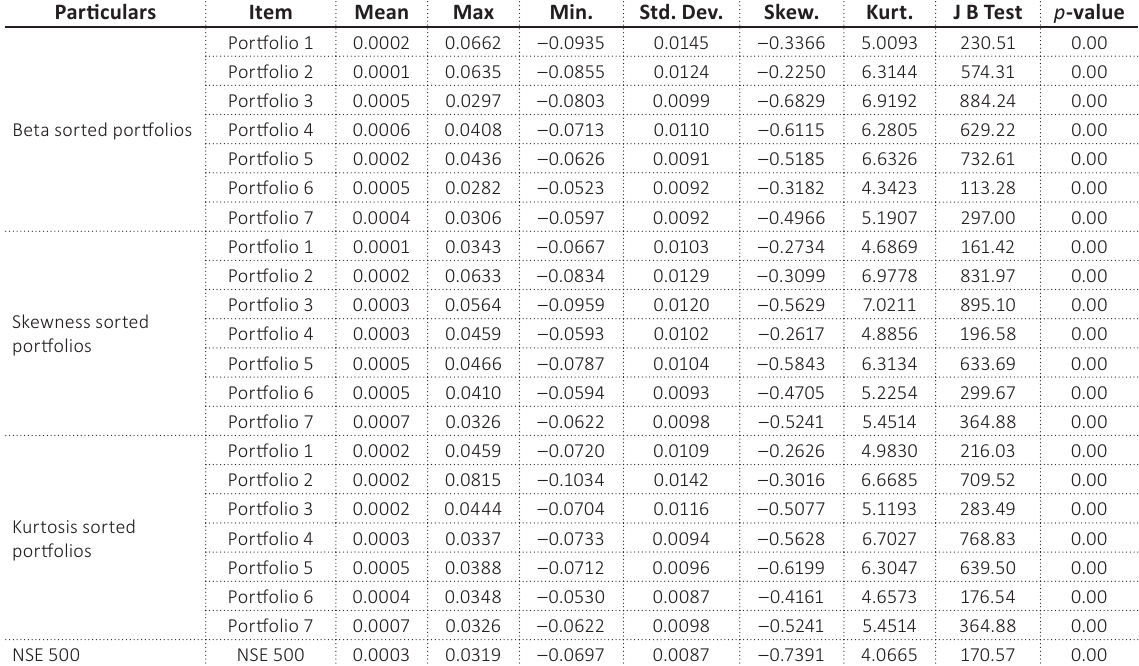
Table 2. Summary statistics of portfolio return